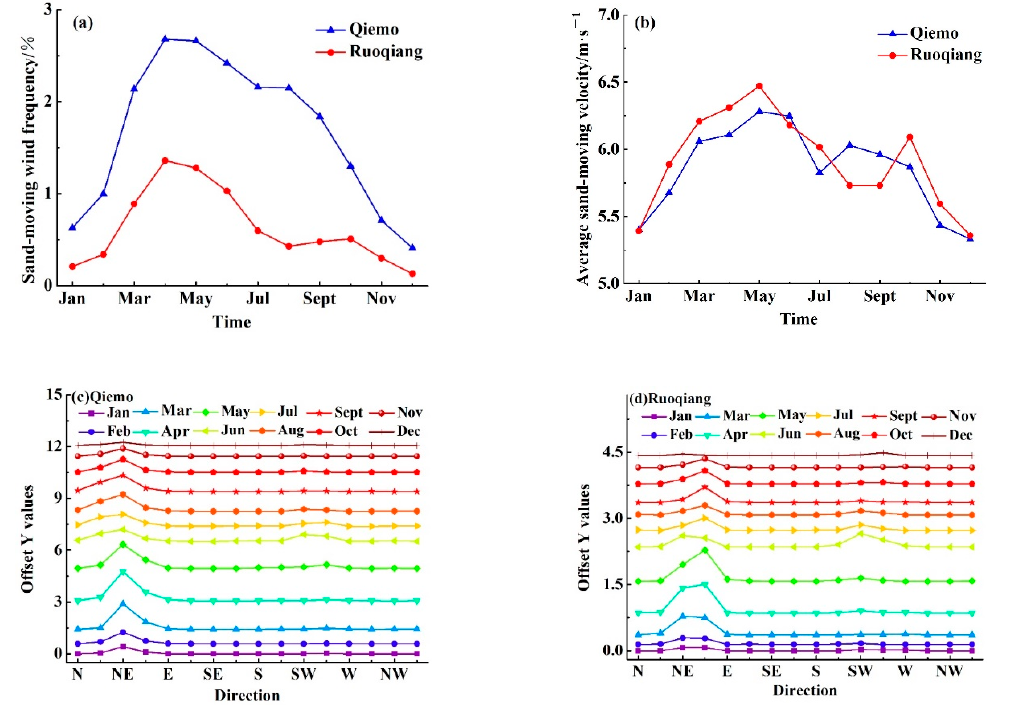
Figure 6. Monthly sand-moving wind frequency and velocity: ( a ) sand-moving wind frequency; ( b ) average sand-moving wind velocity; ( c ) sand-moving wind frequencies in various directions in Qiemo; ( d ) sand-moving wind frequencies in various directions in Ruoqiang.